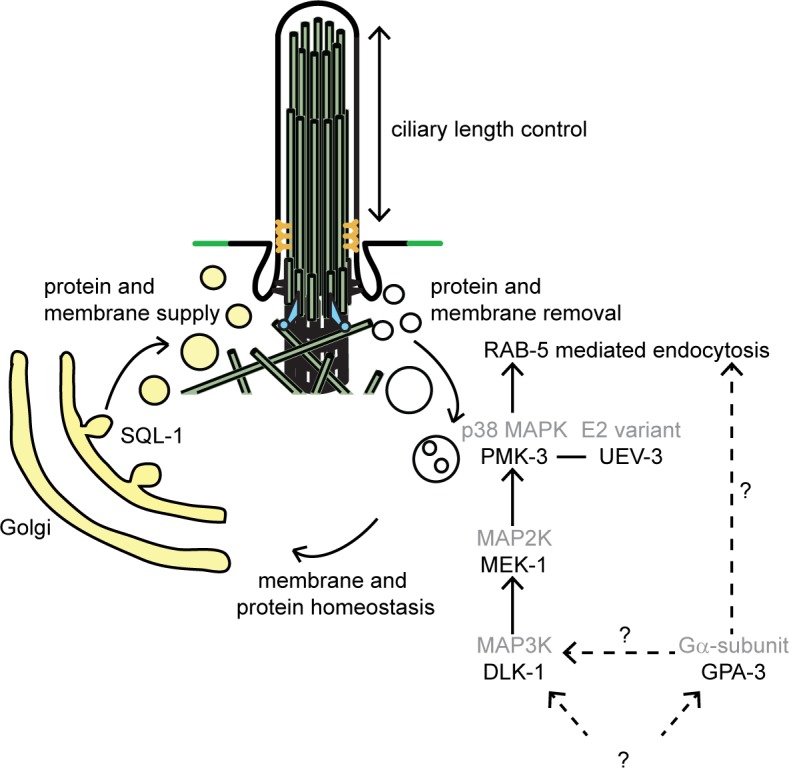
Model of regulation of cilium length by a balance between protein and membrane supply (via the Golgi) and removal (via endocytosis).